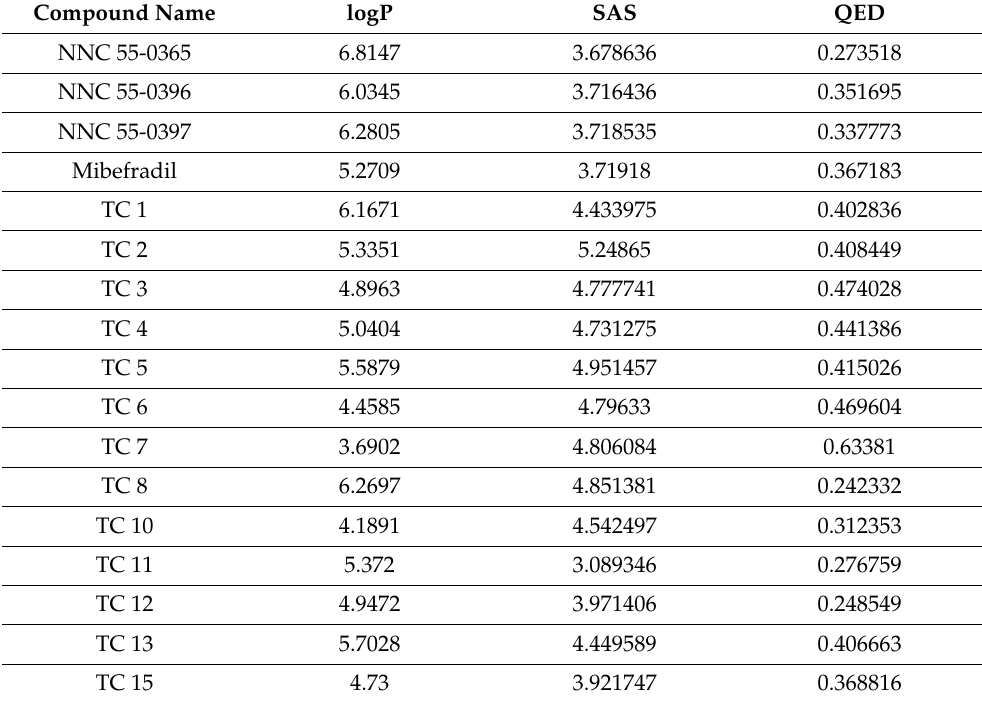
Table 3. The chemical properties of computer-designed compounds and selected TCC blockers. SAS: Synthetic Accessibility Scores, QED: Quantitative Estimation of